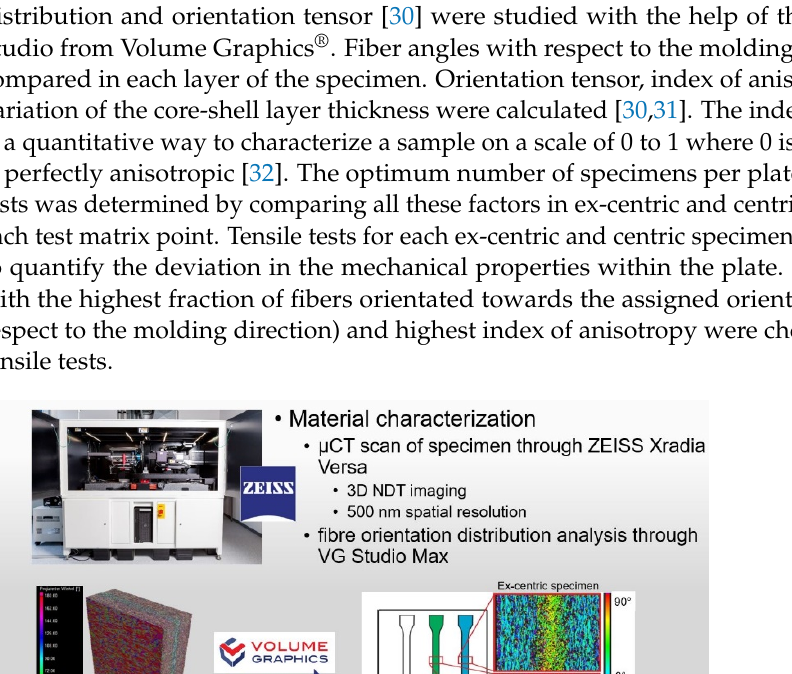
Table 1. Test matrix to produce experimental data for the stress–strain model.